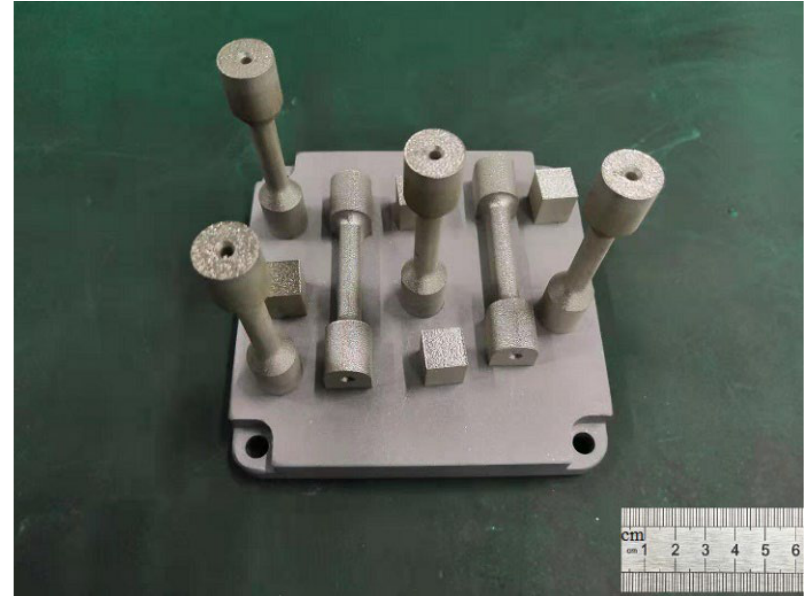
Figure 2. The metallographic and tensile samples. The SLM 304L specimens were etched with aqua regia. Microstructure and imper- fections were characterized with a metallographic microscope (GX51) and a 3-D X-ray microscope (Skyscan2214, Bruker) with an emission current of 35 mA at a bias of 130 kV and a resolution of 3 µ m. The density and hardness were measured with a direct-reading solid density meter (MH-600A) and a hardness tester (HR-150A, Rockwell). The mechani- cal properties were tested by a universal tensile testing machine (E45, MTS). Microstruc- ture observation and fracture analysis were carried out using a scanning electron micro- scope (SU3500) and a field-emission transmission electron microscope (FETEM, Tescan G2 F20,